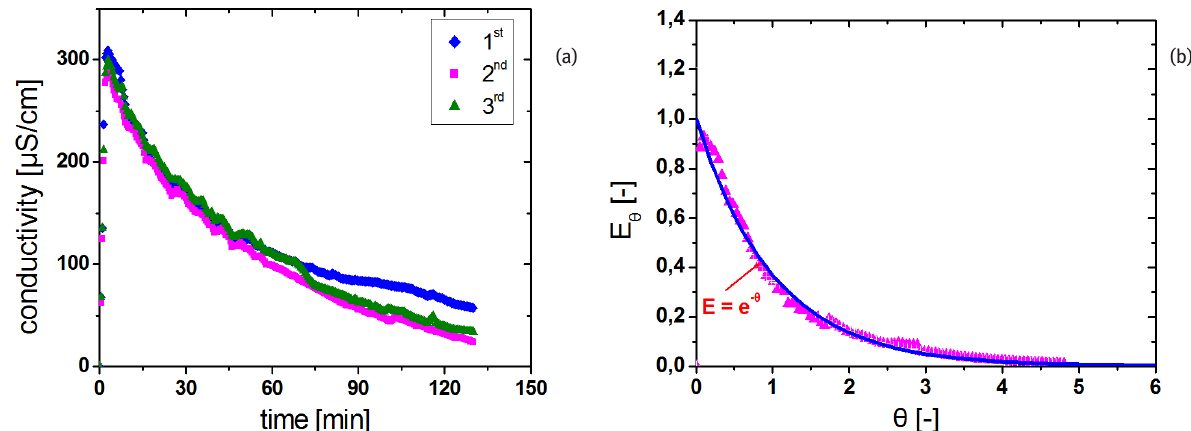
Figure 4 : (a) Conductivity measurements and (b) RTD calculations in the hybrid cell without air; ( L / D = 4) QL = 15.82 cm 3 min -1 , Qg = 0 cm 3 min -1 , hL = 39.7 cm, τ = 188 theoretical